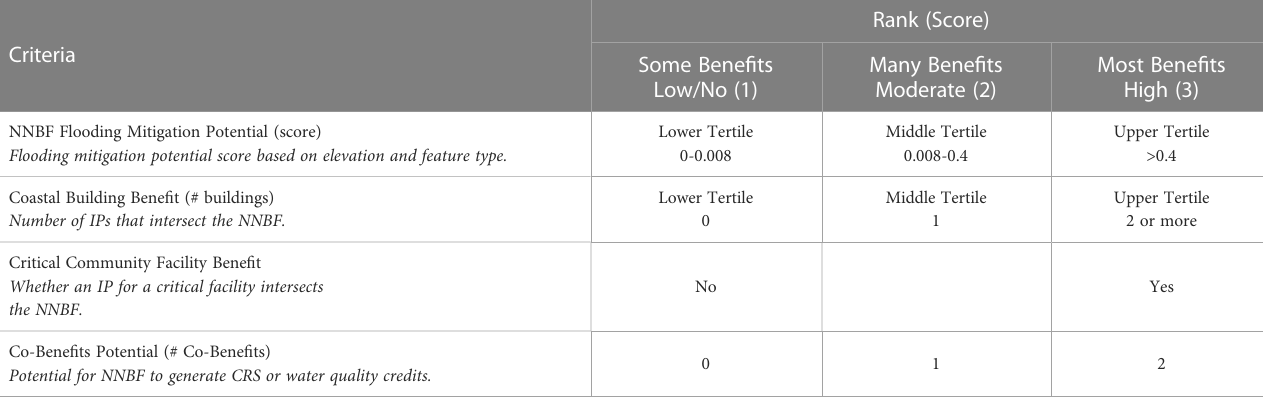
TABLE 4 Ranking and scoring scheme for each of the four criteria considered in the Coastal Bene fi ts Index (CBI).